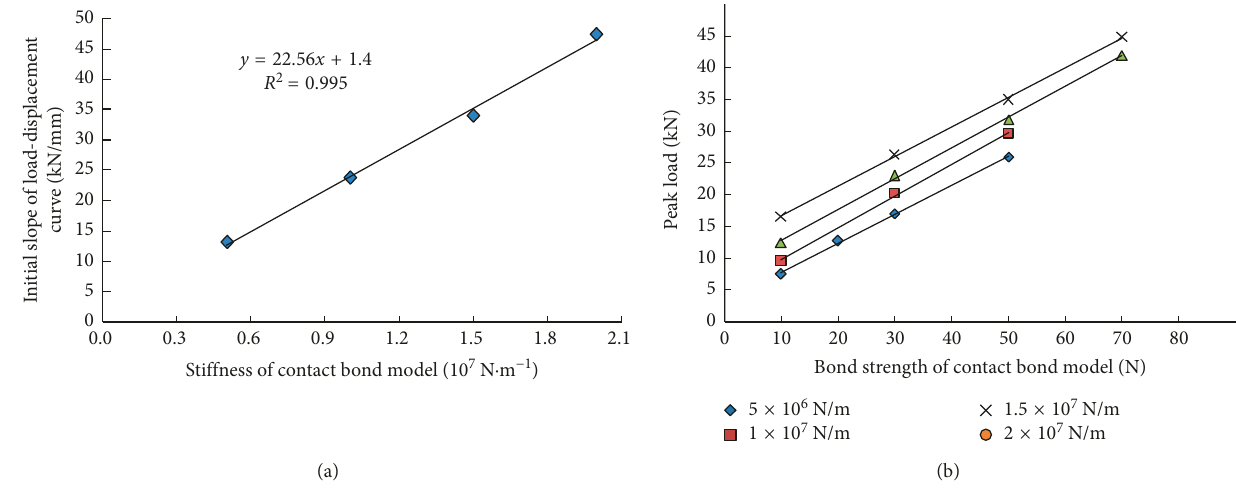
Figure 13: Parameters of the 3D contact bond model. (a) Original slope of the splitting test curve versus stiffness. (b) Peak load of the splitting test versus bond strength.